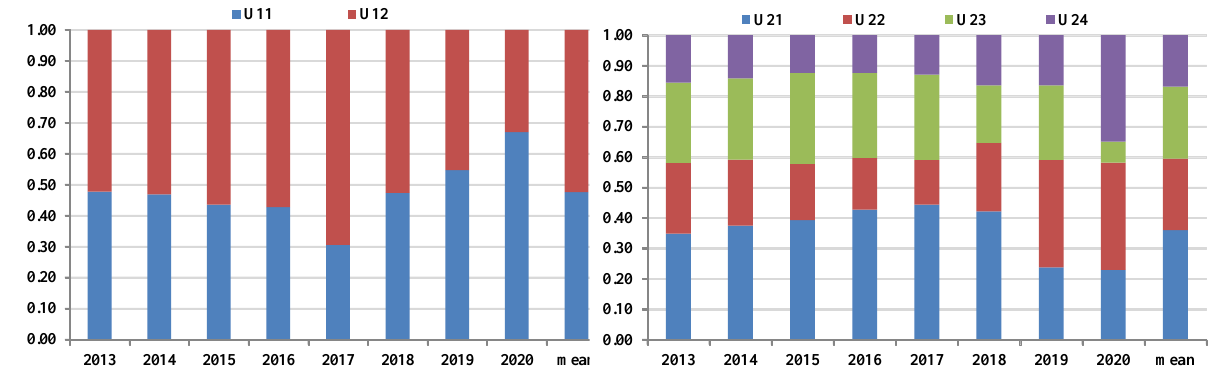
Figure 6. Results of obstacle degree of Anhui Province’s LI and DE.